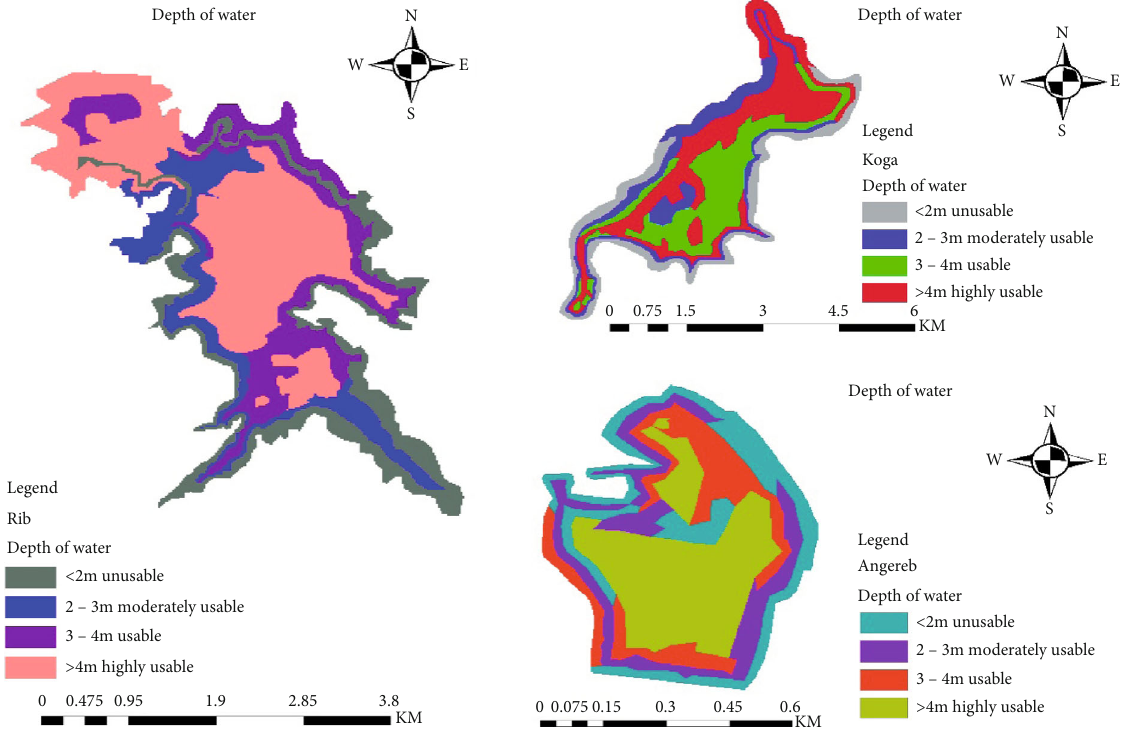
Figure 5: Suitable depth of water surface for fl oating solar